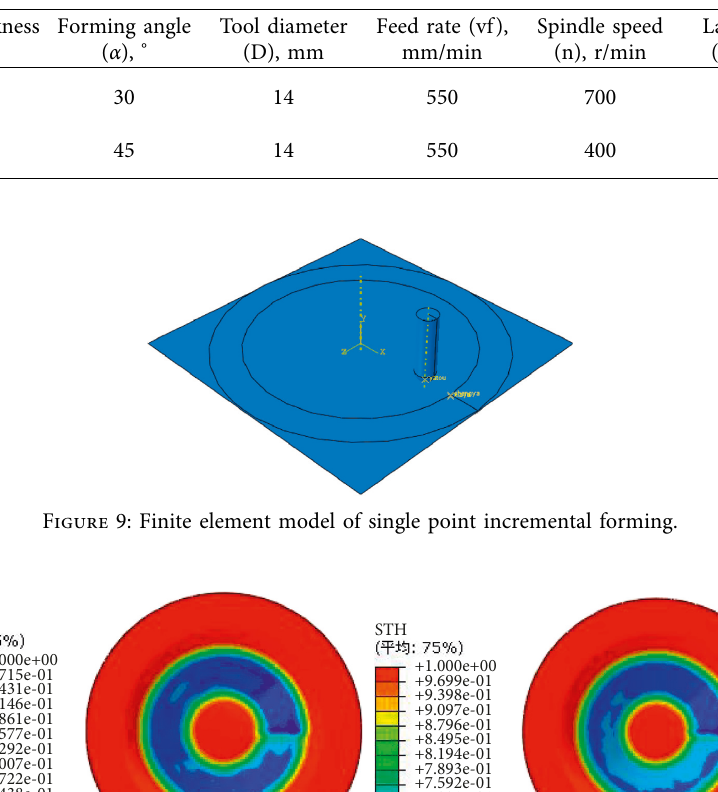
Table 4: Two groups of process parameters.